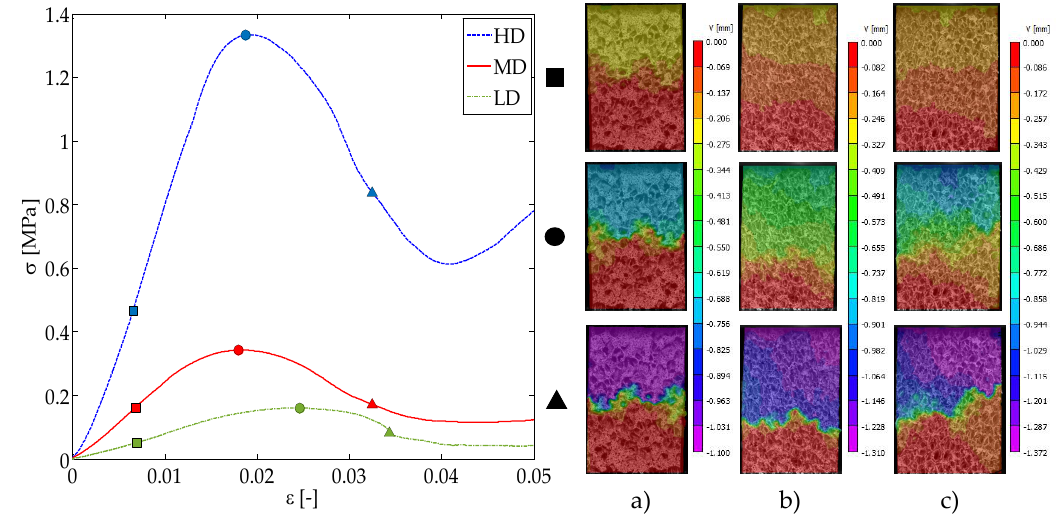
Figure 6. Stress-strain compression response registered for three specimens of different apparent density ( left ). Displacement field for ( a ) HD, ( b ) MD and ( c ) LD specimens ( right ), at the linear stage (square marker), ultimate point (circle marker) and post-yielding (triangle